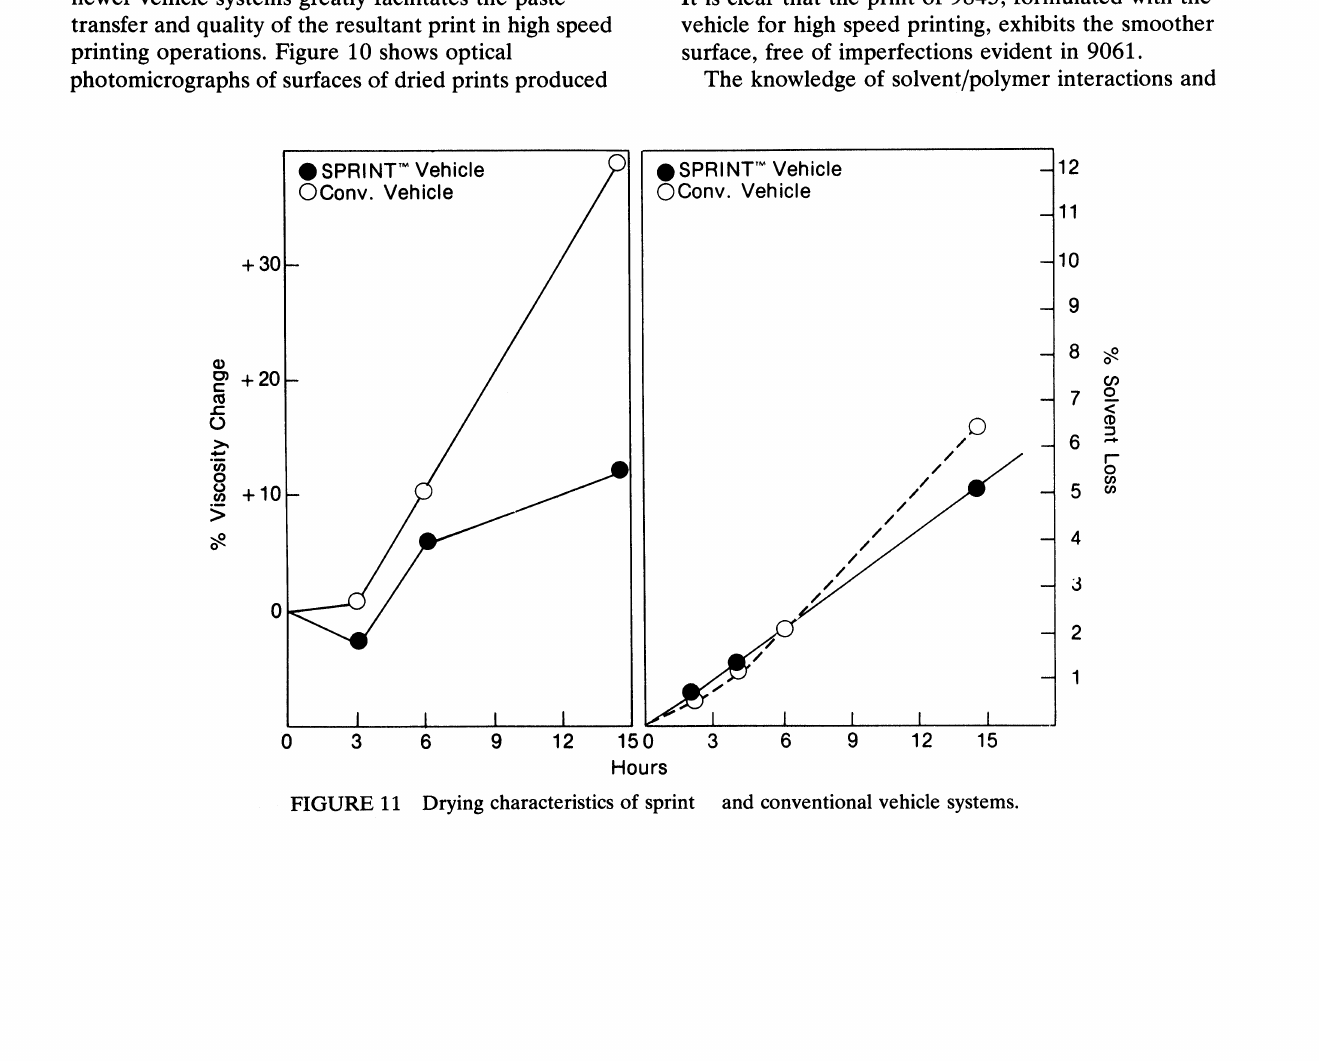
FIGURE 10 Optical photomicrographs (31 x) of Pd/Ag conductors-surfaces of dried prints.